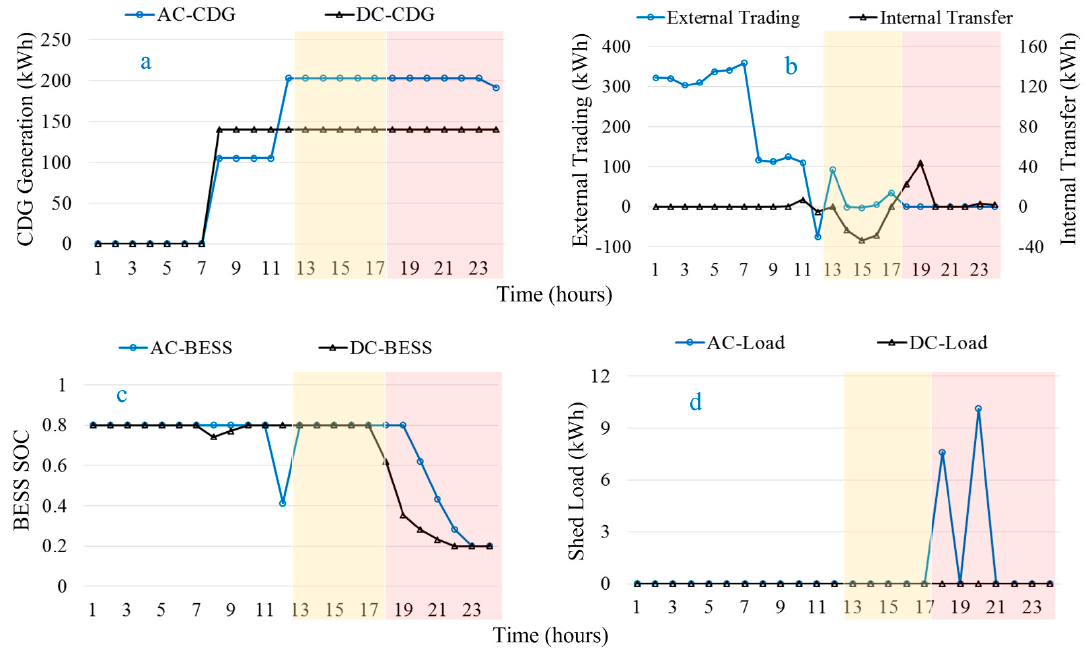
Figure 15. Operation results of proposed strategy: ( a ) CDG generation; ( b ) power trading; ( c ) BESS SOC; ( d ) load